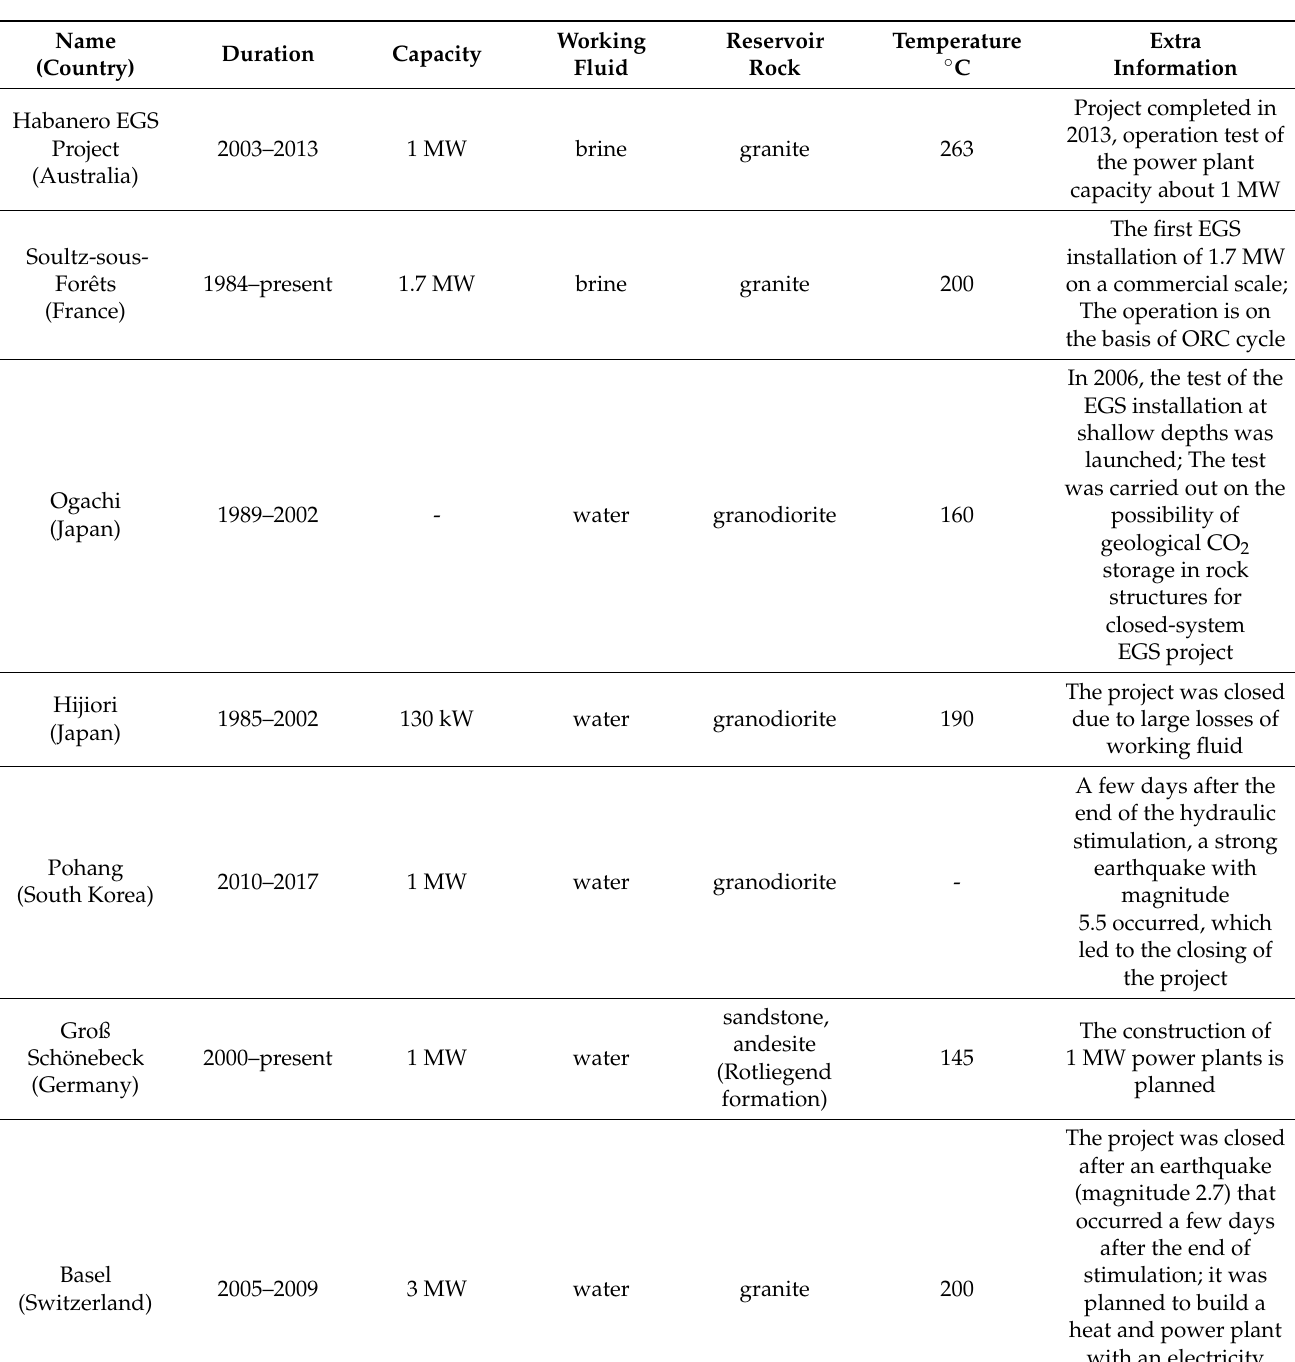
Table 1. Main parameters of selected EGS installations (based on